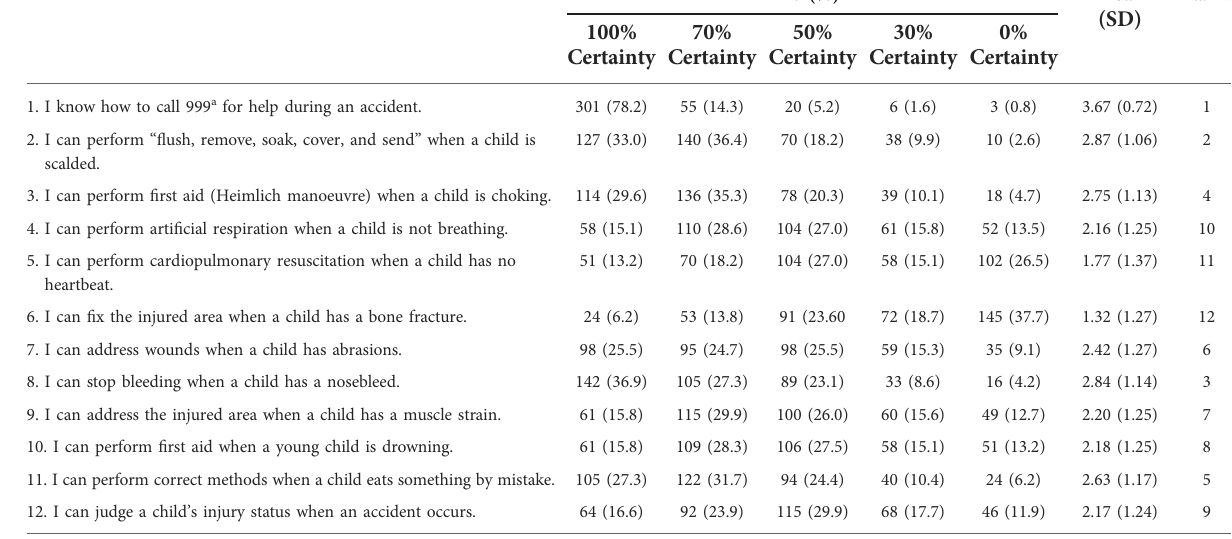
TABLE 2 Self-ef fi cacy of providing emergency management to children involved in home accidents ( N